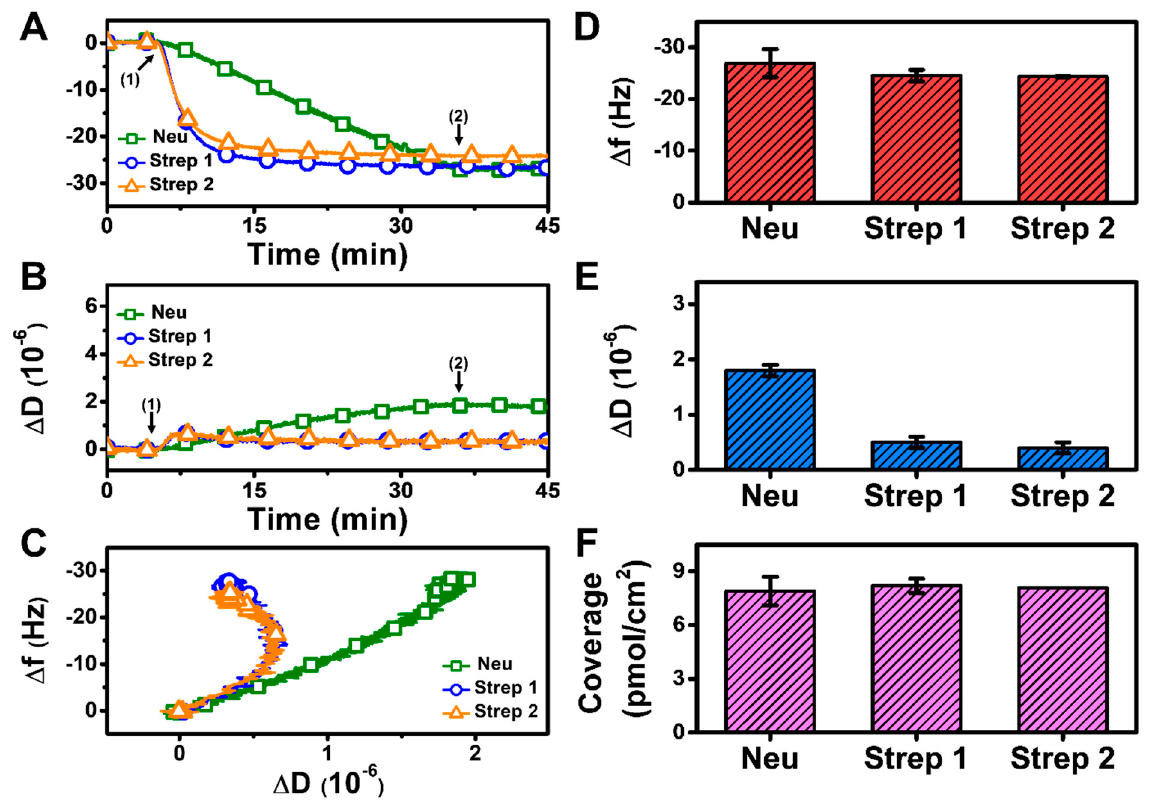
Figure 4. QCM-D measurement responses for Neu and Strep attachment to biotinylated SLB platform at pH 6.3. Time-resolved QCM-D ( A ) frequency ( ∆ f) and ( B ) energy dissipation ( ∆ D) for protein addition. The initial baselines correspond to the shifts for a biotinylated SLB and protein was added starting at t = 5 min (arrow 1), followed by buffer washing from t = 35 min (arrow 2). ( C ) Time-independent curves of ∆ f vs. ∆ D shifts corresponding to data in panels ( A , B ). Final ( D ) ∆ f and ( E ) ∆ D shift values along with ( F ) maximum surface coverage of adsorbed protein molecules on the biotinylated SLB surface are reported as mean ± standard deviation from n = 3 experiments.